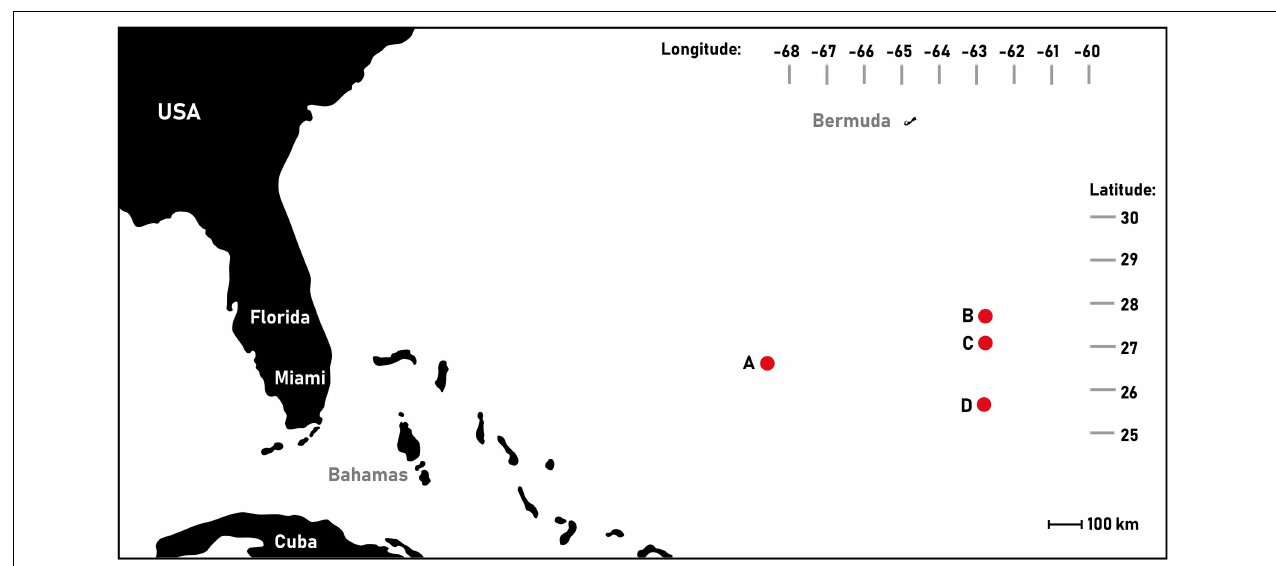
FIGURE 1 | Sampling locations of European eel ( Anguilla anguilla ) leptocephalus larvae in the Sargasso Sea. This map was created using BatchGeo (07.04.2015, https://batchgeo.com/). (A) West, (B) North east, (C) Mid-east, and (D)